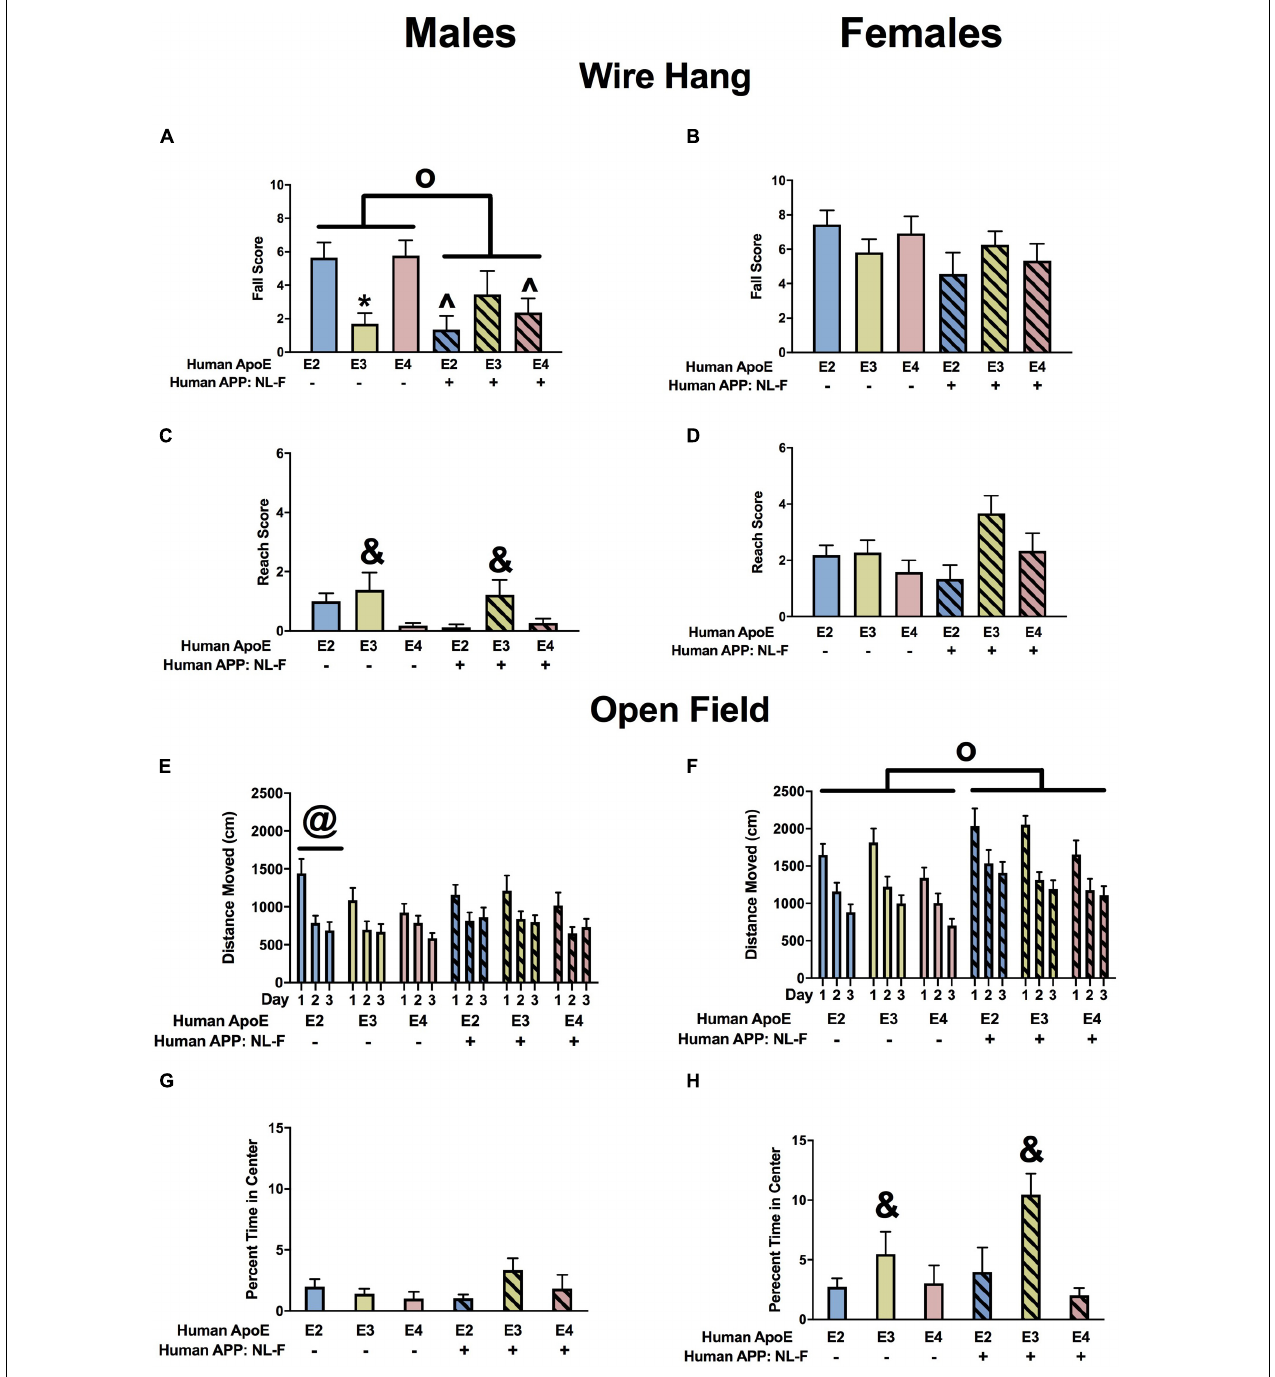
FIGURE 10 | Performance of males (A,C,E,G) and females (B,D,F,H) in the wire hang and open field tests at the 18-month time point. (A) There was an effect of APP and an APP × APOE interaction for fall scores of males in the wire hang test. E3 males had lower fall scores than E2 and E4 males. * p < 0.05. NL-F/E2 and NL-F/E4 males had lower fall scores than E2 and E4 males, respectively. ˆ p < 0.05. N-L-F males had lower fall scores. o p < 0.05. (B) Fall scores of females in the wire hang test. (C) There was an effect of APOE on reach scores in the wire hang test. E3 males had higher reach scores than E4 males. & p < 0.05. (D) There was a trend toward an effect of APOE on reach scores in the wire hang test. (E) There was an APP × APOE interaction for activity levels of males in the open field. E2 males were more active than E3 and E4 males on days 1 and 3 and E2 and E4 males were more active than E3 males on day 2. @ p < 0.05. (F) There was an effect of APP on activity of females in the open field. NL-F females were more active in the open field. o p < 0.05. (G) Percent time males spent in the center of the open field. (H) There was an effect of APOE on percent time females spent in the center of the open field. E3 females spent more time in the center of the open field than E2 and E4 females. & p <